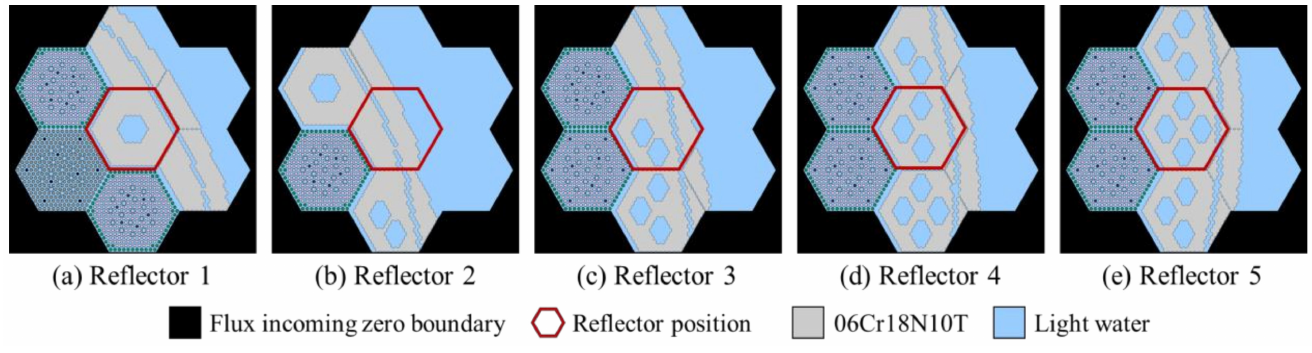
Figure 6. Radial layout of 2D radial reflector model.